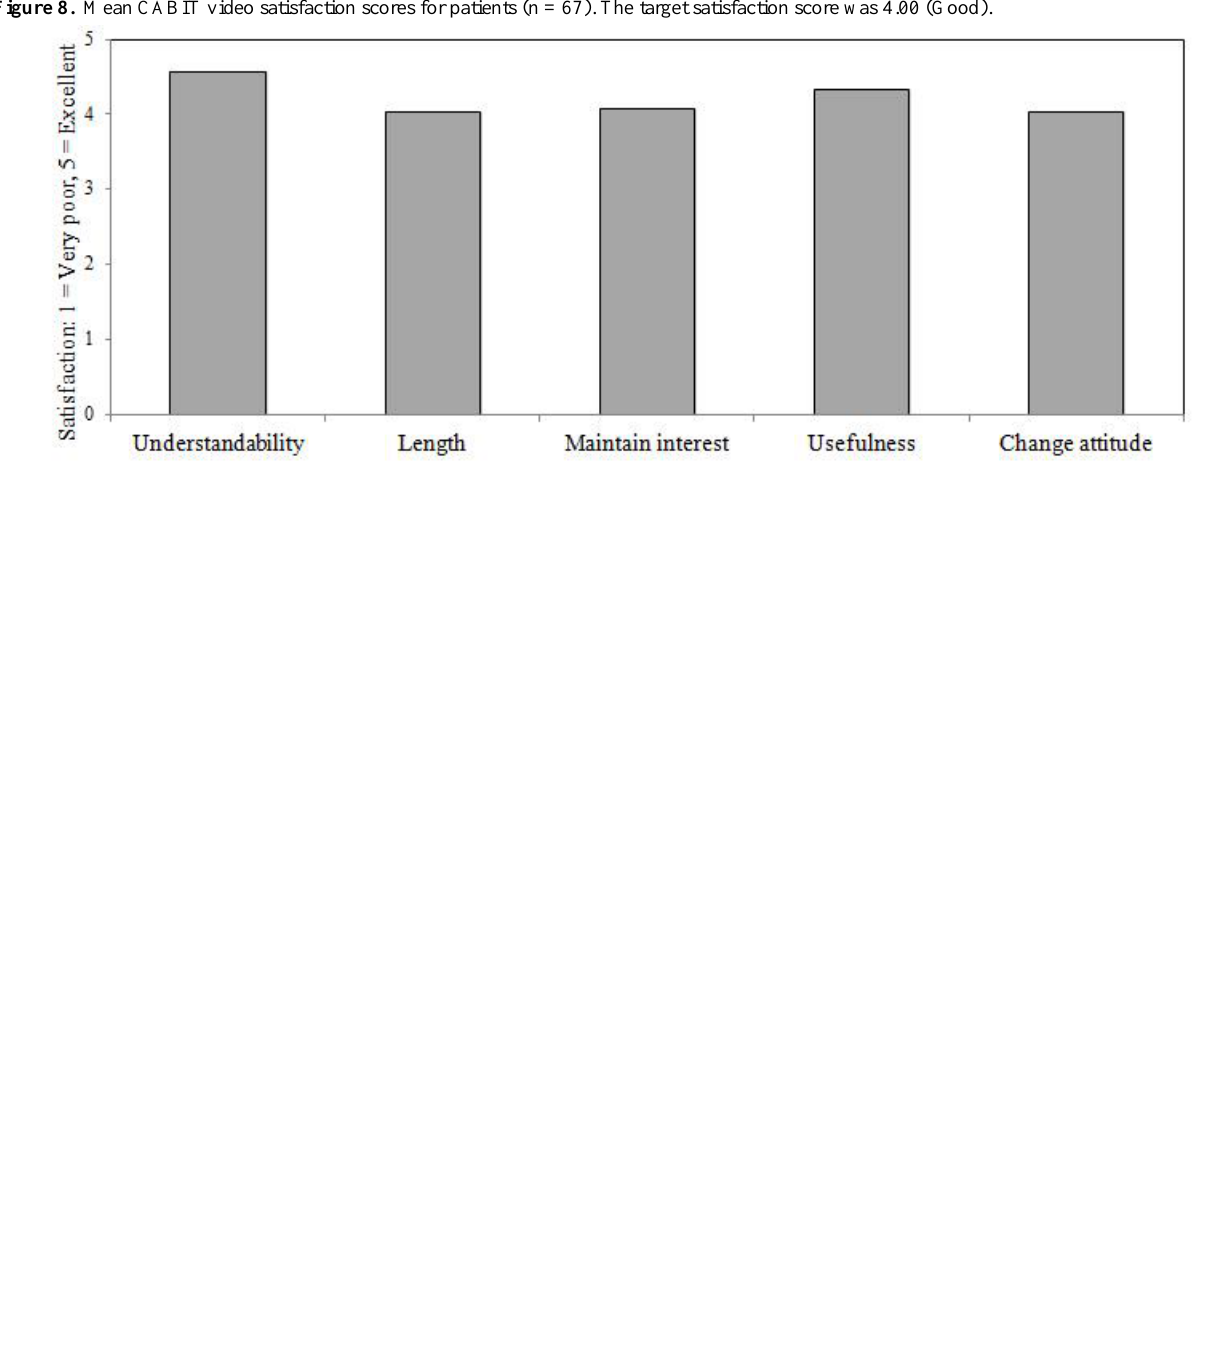
Figure 8. Mean CABIT video satisfaction scores for patients (n = 67). The target satisfaction score was 4.00